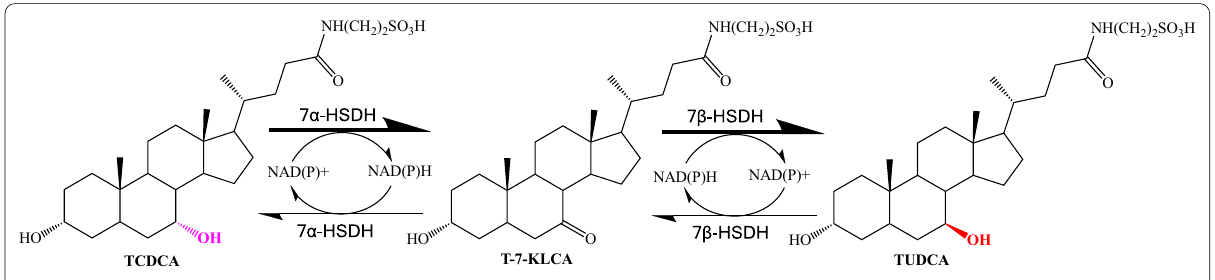
Fig.1 Reaction catalyzed by 7α-HSDH and